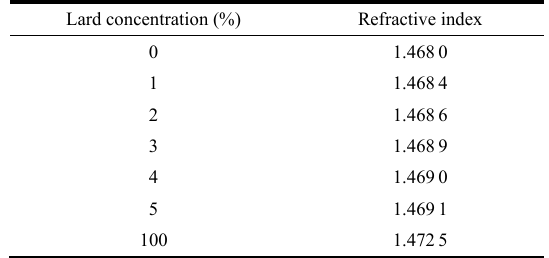
Table 1 Refractive index of olive oil as the variation of lard concentration in olive